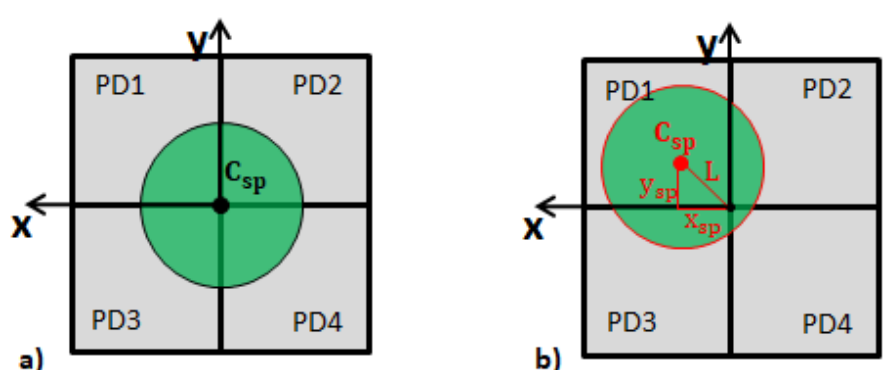
Figure 6. A perfectly round speckle, which is initially in the center of the measurement diodes is shown ( a ). The diode signals (P1, P2, P3, P4) can be used to compute its center of gravity C sp ( x sp , y sp ) and its total vector length L in order to detect speckle movements ( b